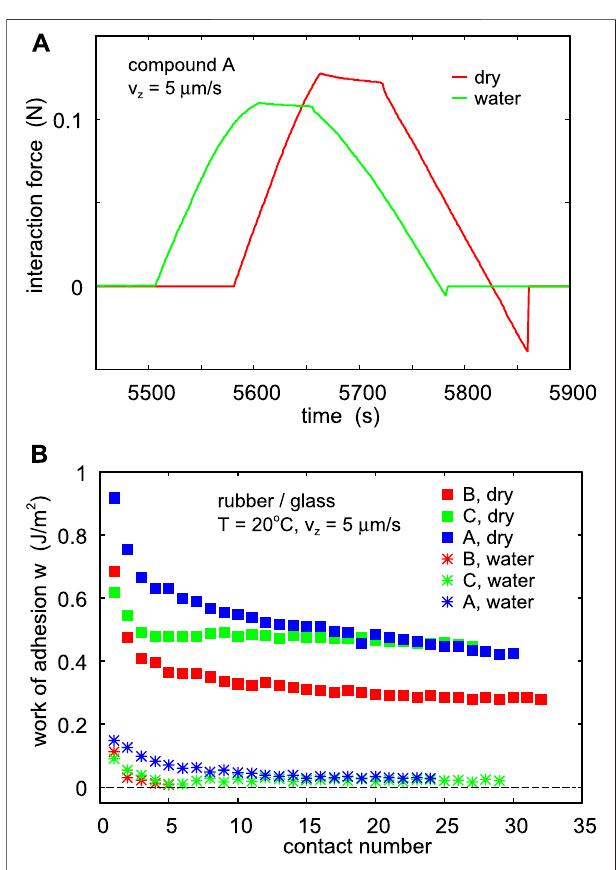
FIGURE 5 | (A) The interaction force between a glass ball and the rubber compoundAasafunctionoftime.Resultsareshownindrycondition(red)andwhen immersed in water (green). The rubber surface was cleaned with hot water and the glass ball with acetone. The glass ball moved up and down with the speed 5 μ m / s. (B) TheworkofadhesionbetweenaglassballandtherubbercompoundA, B,andCfordrycontactandin water.Therubbersurfacesaresmoothandcleaned with hot water just before start of the experiments. The glass ball was cleaned with acetone. The pull-off speed vz (cid:1) 5 μ m/s and the temperature T (cid:1) 20 °